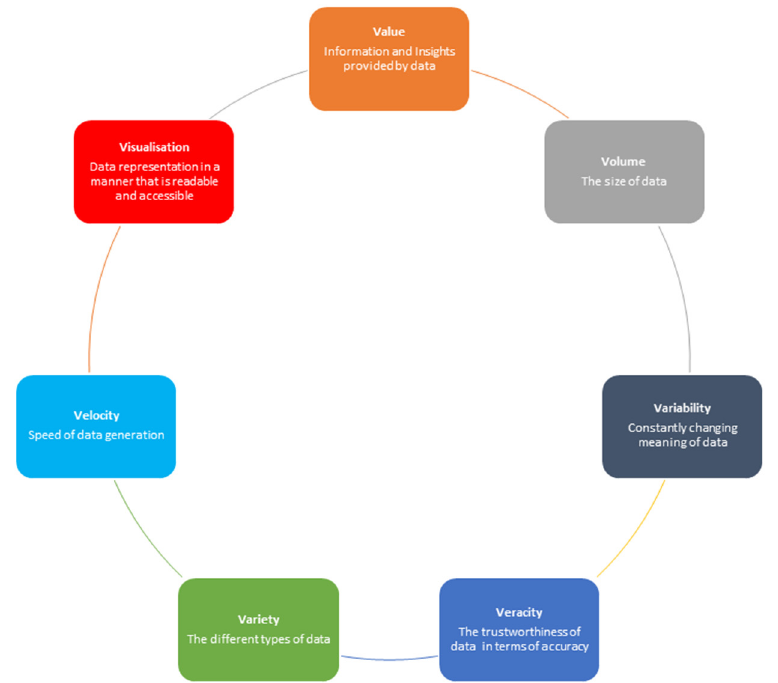
Figure 10. The seven Vs of big data.